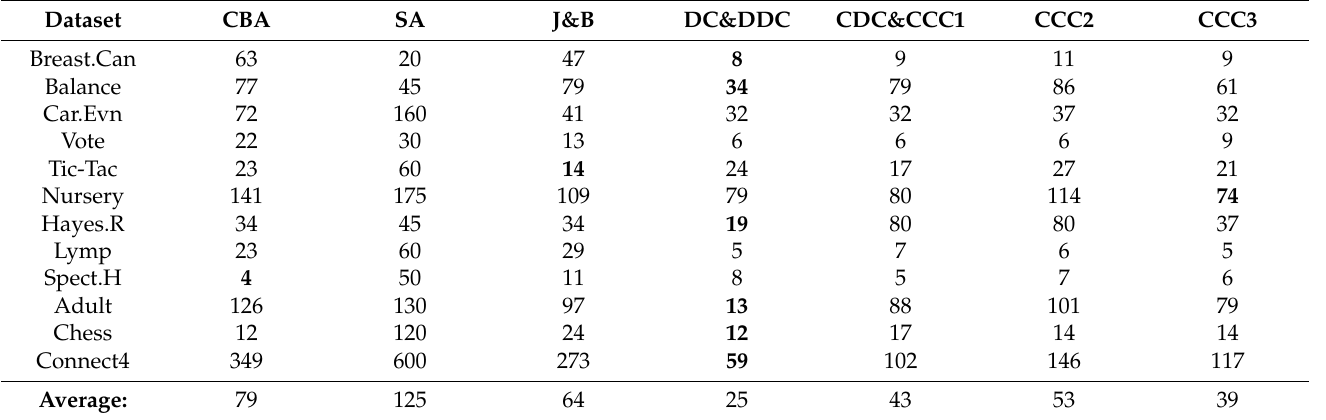
Table 6. Number of CARs.